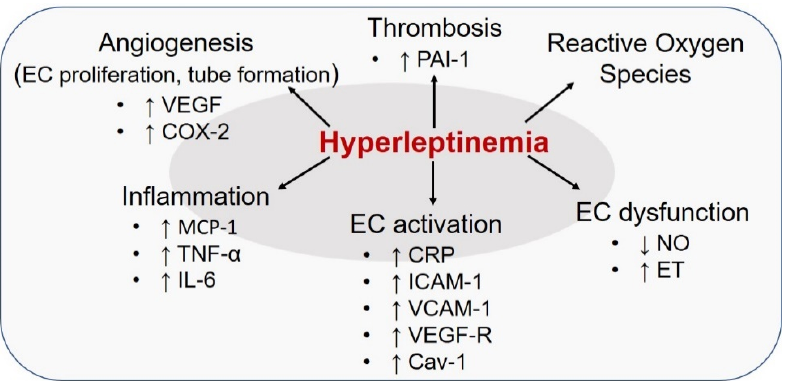
Figure 3. Effect of hyperleptinemia on endothelial cells in the vessel wall triggering atherosclero- sis. VEGF: vascular endothelial growth factor; COX-2: cyclooxygenase-2; ICAM-1: intercellular adhesion molecule-1; VCAM-1: vascular cell adhesion molecule-1; MCP-1: monocyte chemoattractant protein-1; TNF- α : tumor necrosis factor- α ; IL-6: interleuikin-6; CRP: C-reactive protein; PAI-1: plasminogen activator inhibitor-1; Cav-1: caveolin-1; ET: endothelin-1; NO: nitric oxide. Please see text for additional details.